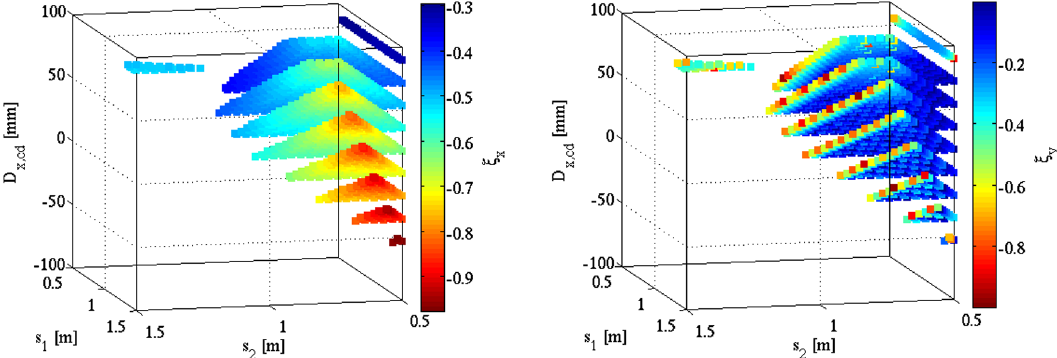
amplitudes.FIG. 8. Parametrization of the horizontal (left) and vertical (right) chromaticity with the drift spaces lengths s 1 and s 2 and the horizontal dispersion at the middle of the dipole, for a detuned cell ( ϵ